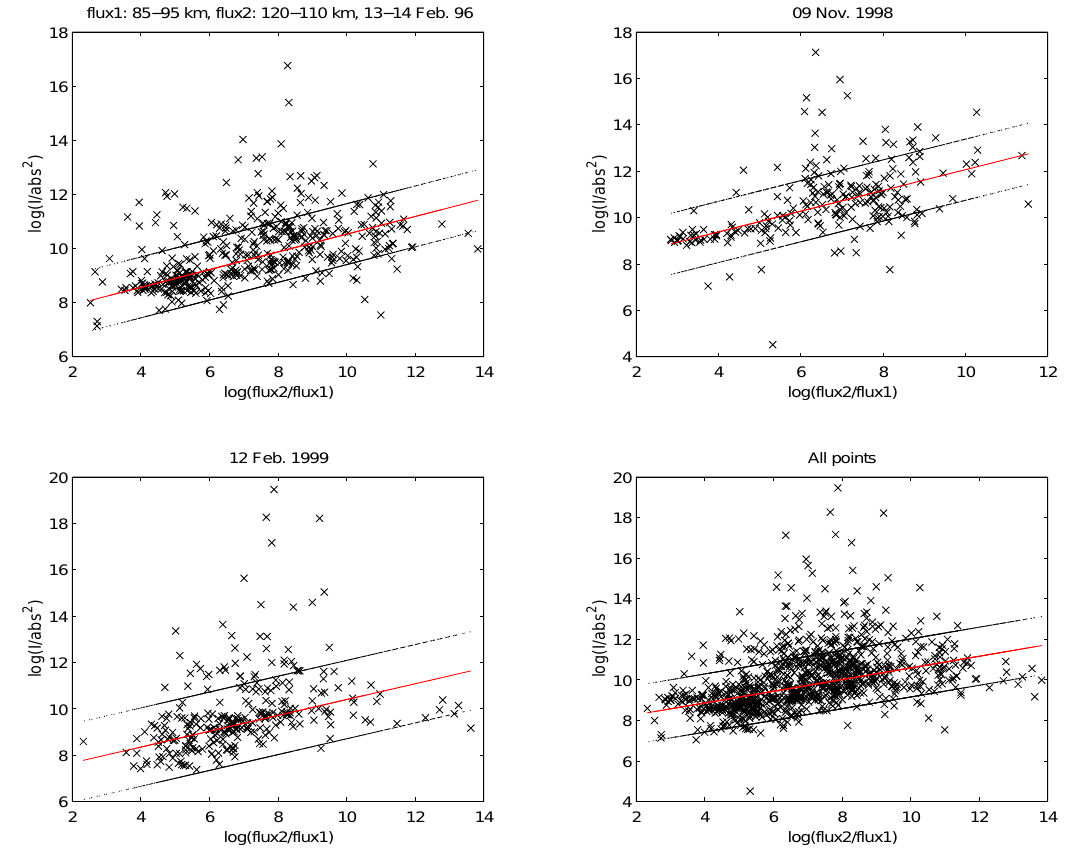
Fig. 4. Dispersion plots between the logarithm of the ratio of the optical intensity to the square of absorption (Int/Abs 2 ), and the logarithm of the ratio of the corresponding fluxes ( F 2 /F 1 ), for the same data sets as in Fig. 3 (panels (a) , (b) , and (c) ). Panel (d) displays all the data points together. The regression lines are shown in red while the dotted lines on both sides give the interval at one standard deviation.